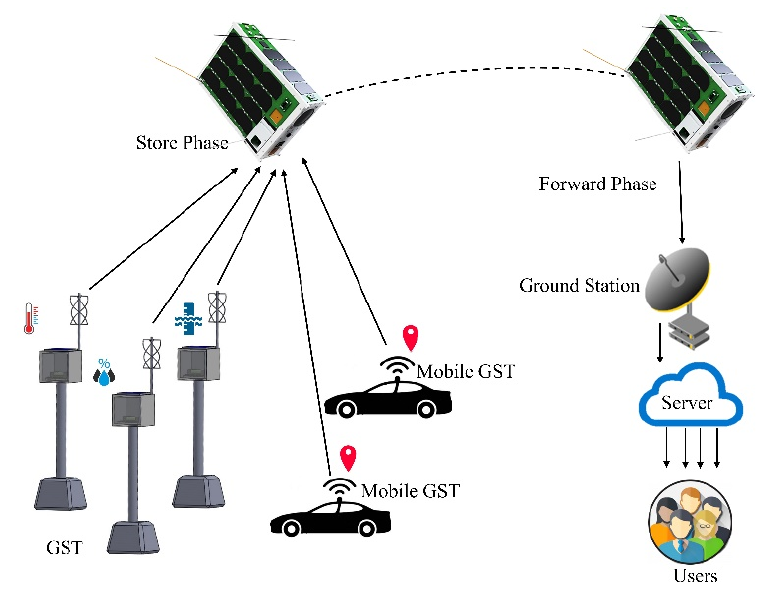
Figure 2. Illustration for a satellite ‐ based S&F system.